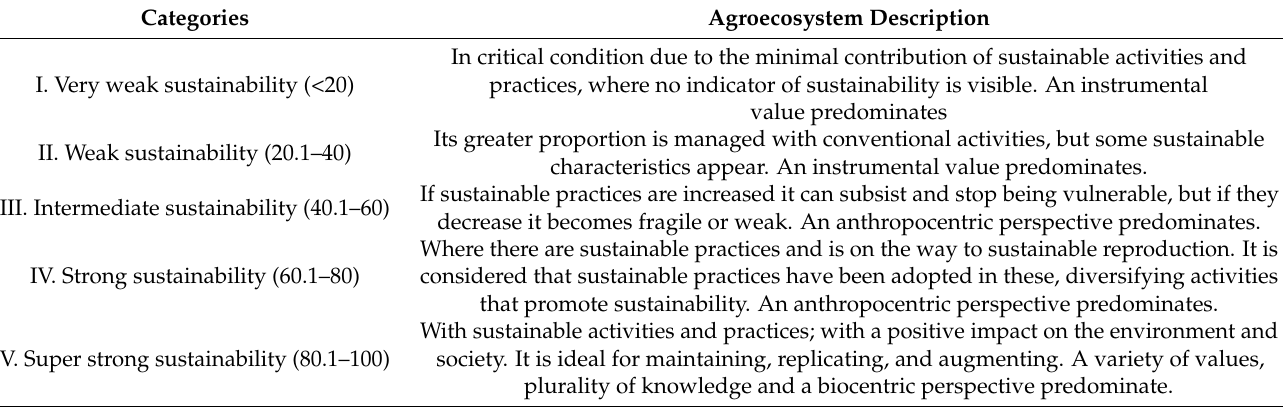
Table 3. The sustainability scale and its five